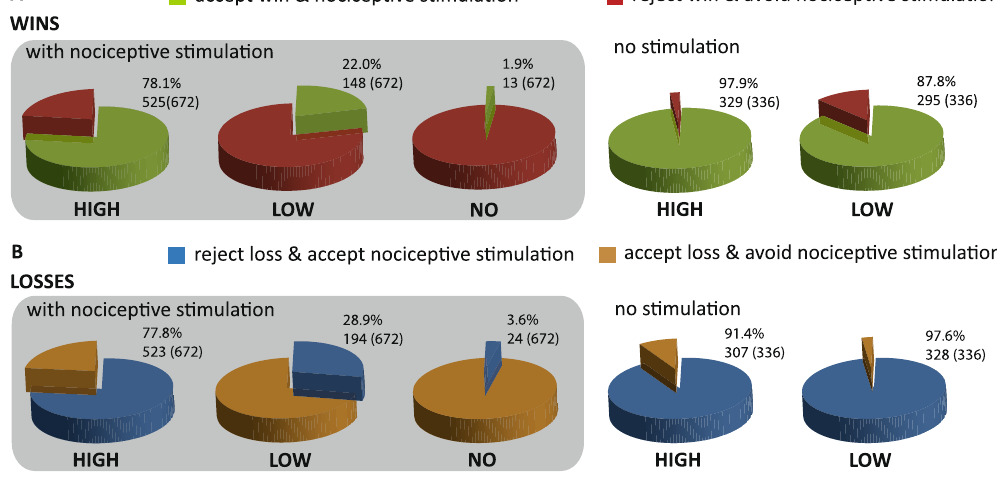
Figure 2. Choice behavior. ( A ) Percentage and absolute (out of) number of trials of accepted (green) vs. rejected (red) monetary wins coupled to a nociceptive stimulus ( win trials). ( B ) Percentage and absolute (out of) number of trials of accepted (blue) vs. rejected (yellow) monetary losses coupled to pain avoidance ( lose trials).